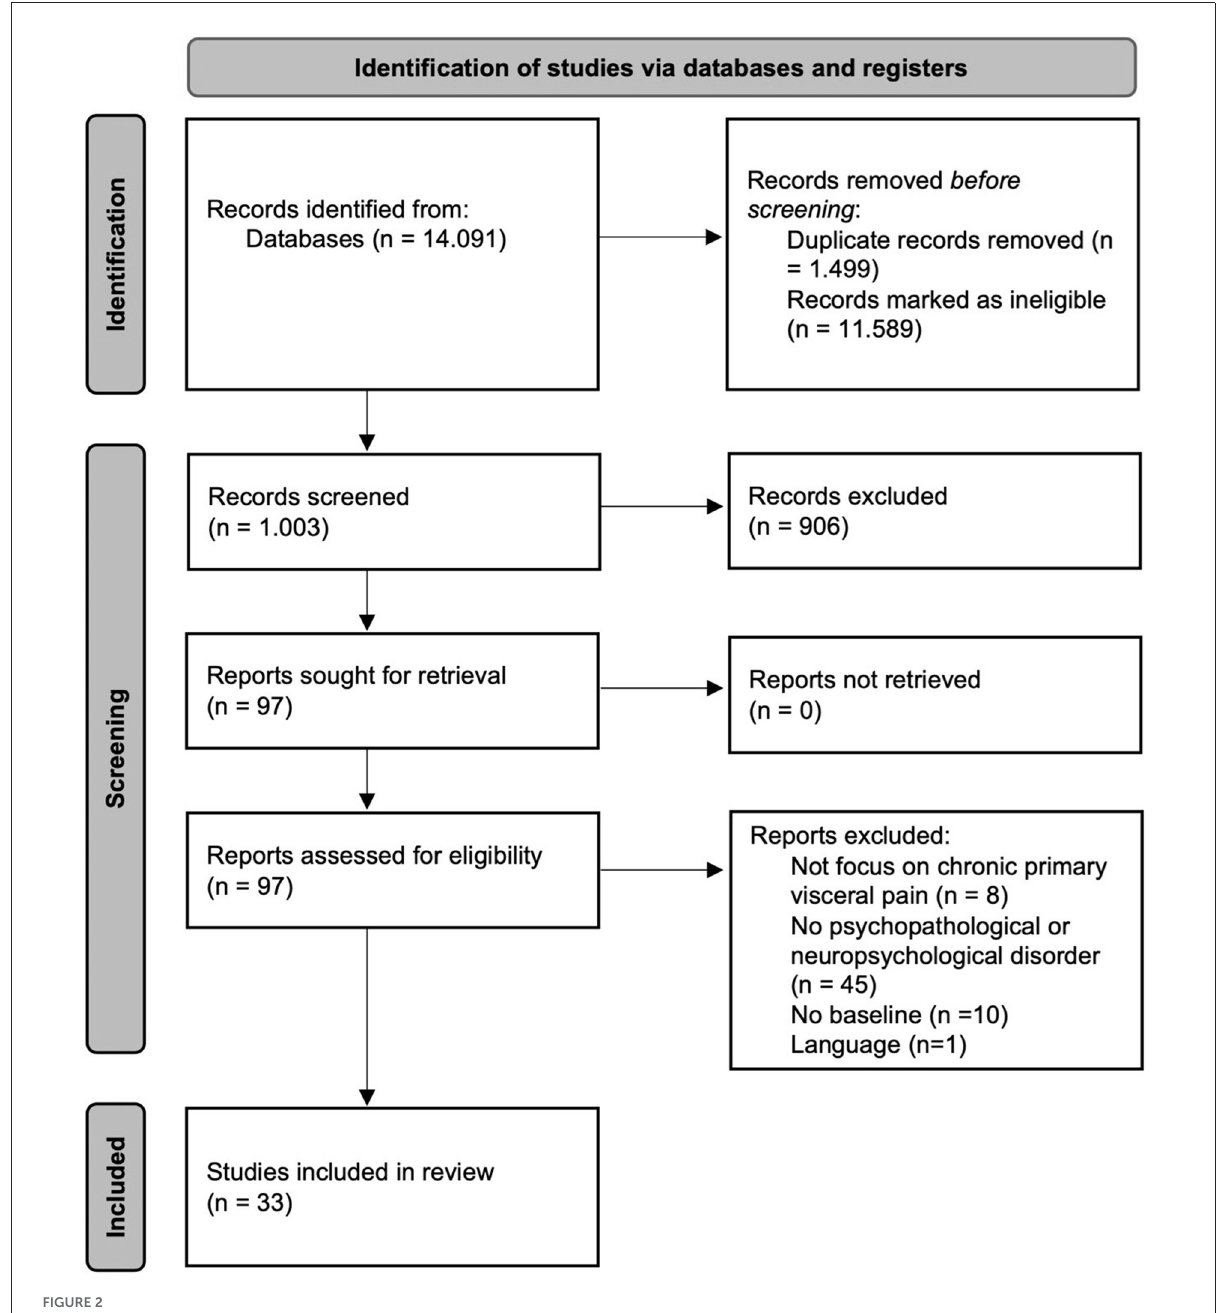
FIGURE2 PRISMA flow diagram (Page et al.,